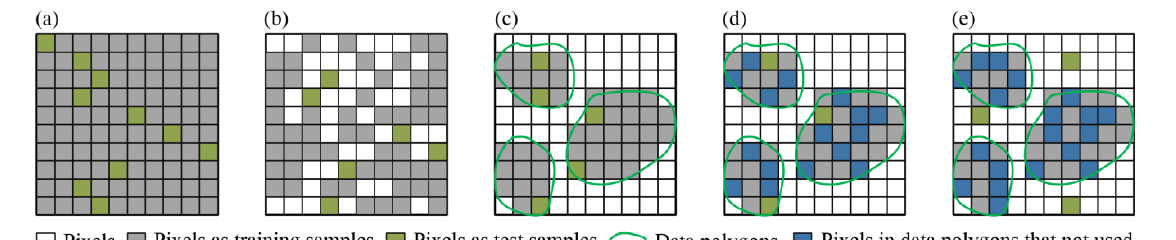
Figure 11. Different sampling designs of training and test samples (taking the proportion of 9:1 as